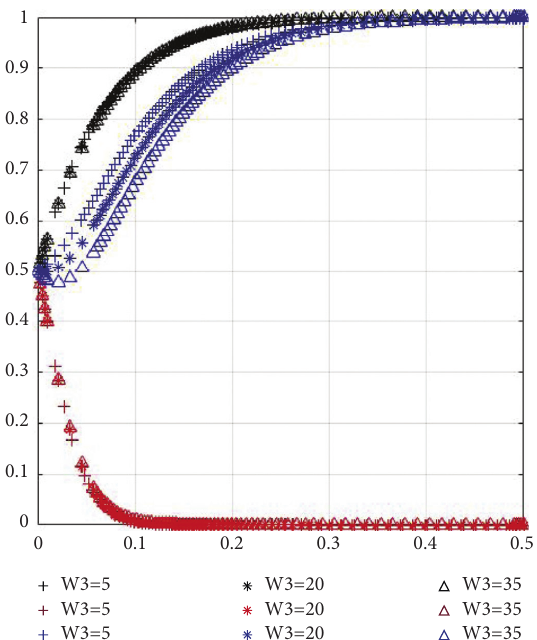
Figure 13: Public’s loss caused by illegal information released by We Media ( W 3 � 5 ⟶ W 3 � 10 ⟶ W 3 �